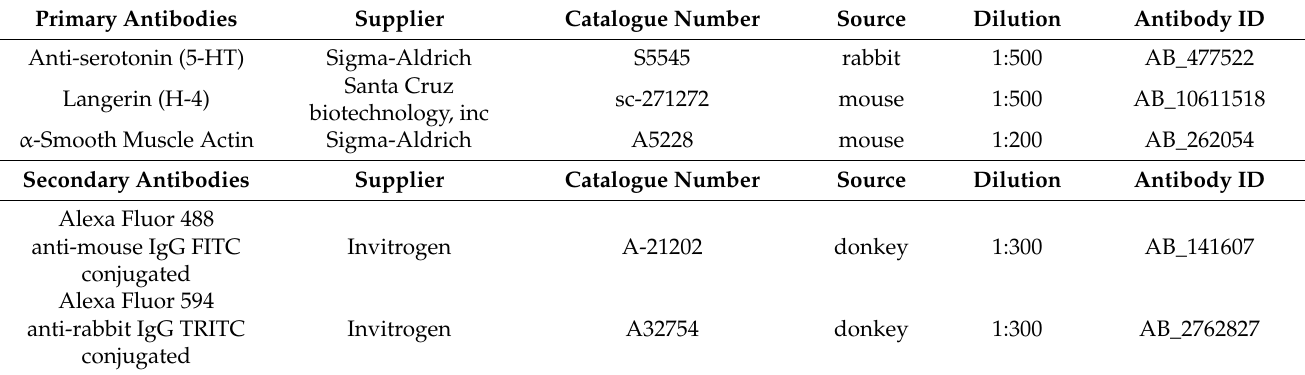
Table 2. Summary of primary and secondary